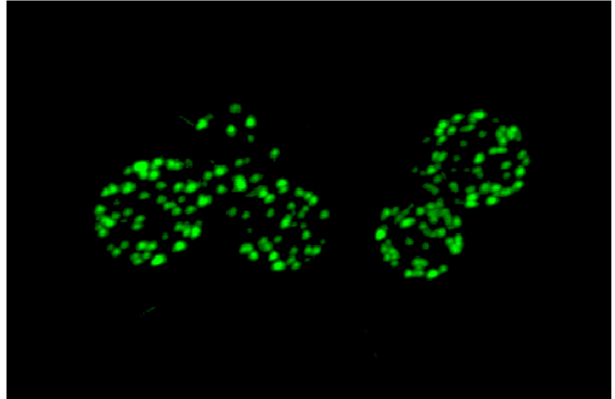
Figure 1. Punctate localization of Sur7-GFP in S. cerevisiae . Deconvolution microscopy was used to create a three dimensional reconstruction of Sur7-GFP localization.